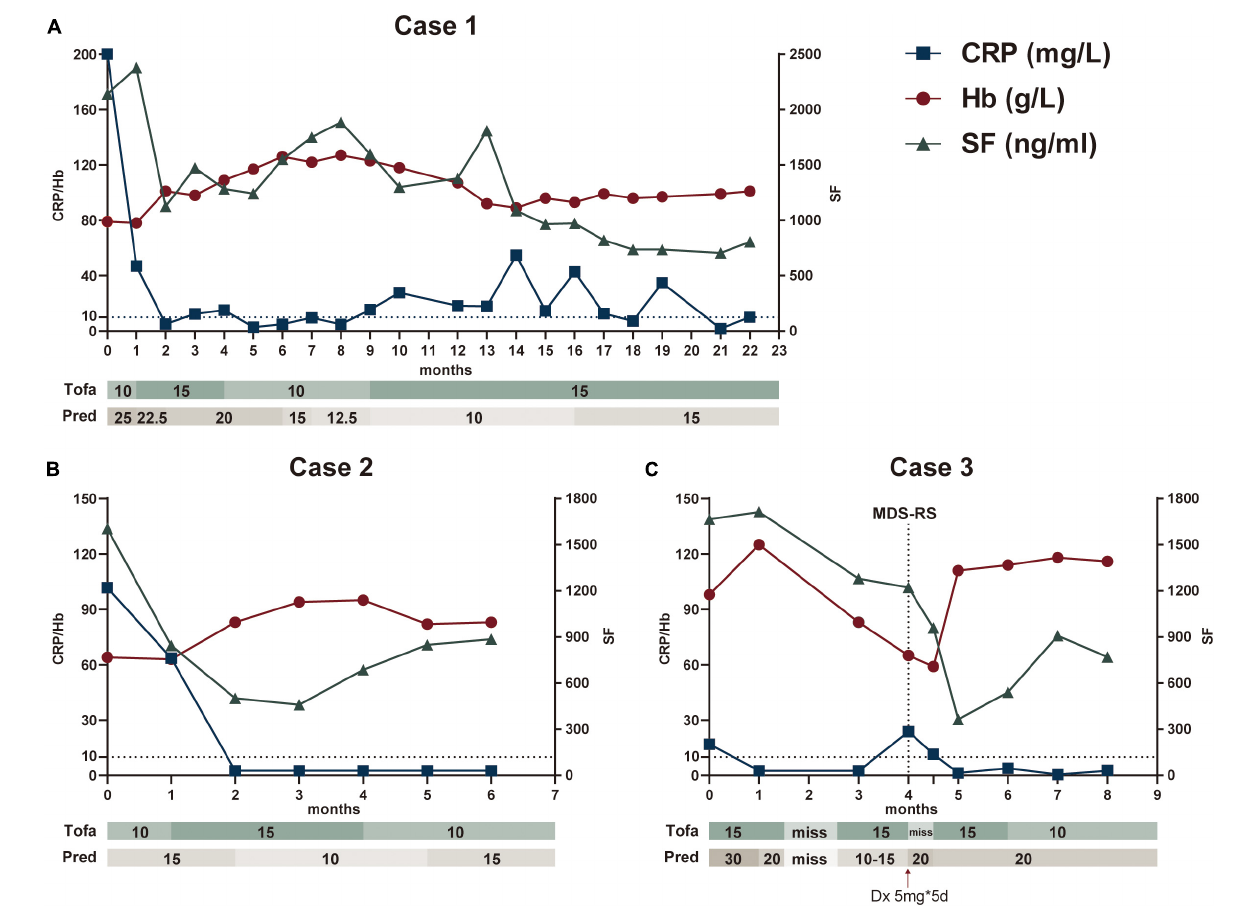
FIGURE 1 | Main clinical and biologic findings and therapeutic interventions in three patients treated with tofacitinib. The Figures illustrated Case 1 (A) , Case 2 (B) , and Case 3 (C) , respectively. CRP and Hb referred to the left Y axis, SF referred to the right Y axis. CRP, C-reaction protein; Hb, hemoglobin; SF, serum ferritin; Tofa, tofacitinib (mg/day); Pred, prednisone (mg/day); Dx, dexamethasone; MDS-RS, Myelodysplastic Syndrome with ring